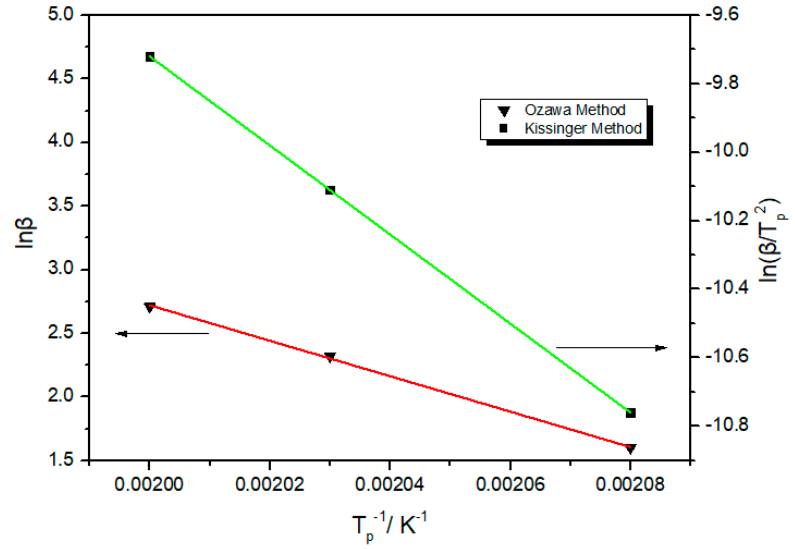
Figure 5. Kissinger method and Ozawa method fitting figure of ZAA.